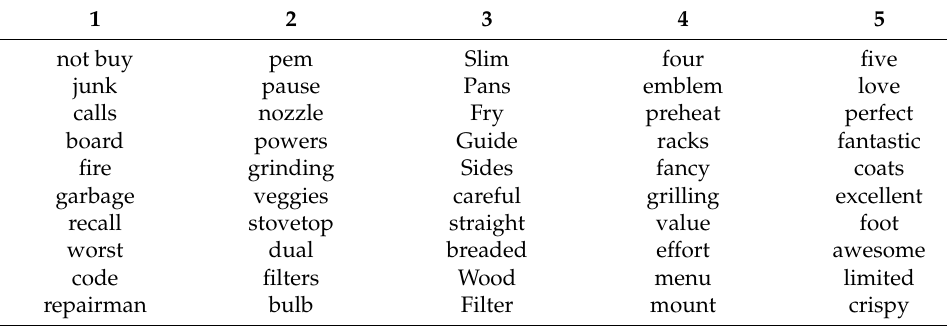
Table 3. Top 10 feature terms related to each star (microwave